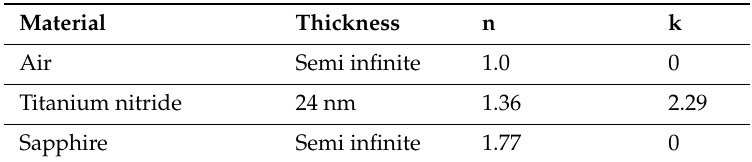
Table 1. Thickness and optical parameters of the TiN thin film, which better fit the attenuated total reflectance (ATR) spectrum of Figure